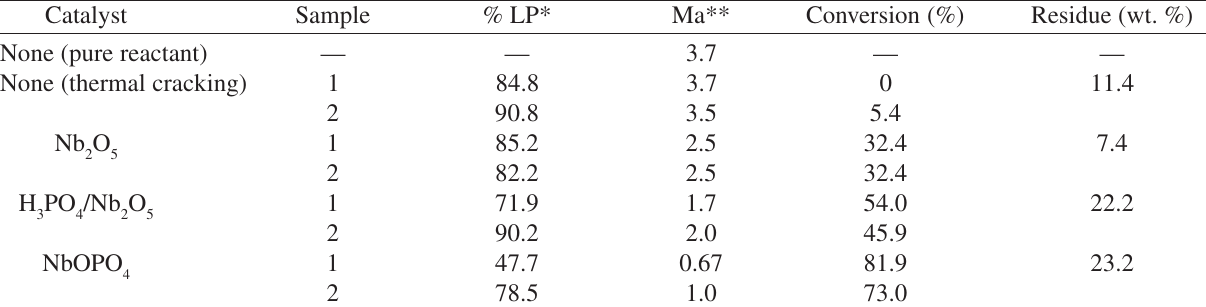
Table 3. Summary results from catalytic tests with oleic acid at 623 K. Catalyst